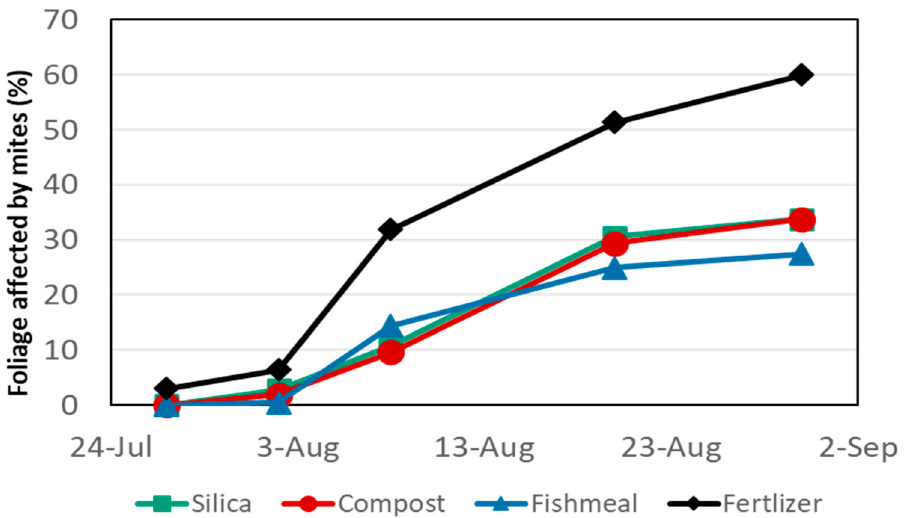
Figure 3. Effect of soil amendments on the development and damage caused by spider mite infestation on green beans in in 2018 season. Compost = Composted dairy manure; Silica = Compost plus silicon (Si) as Wollastonite; Fish meal = Compost plus organic fish meal (high N fertilizer); Fertilizer = commercial organic fertilizer-only treatment (no compost).